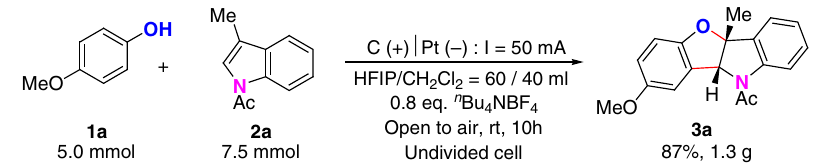
Fig. 5 Electrochemical gram scale reaction. Gram scale synthesis of benzofuro[3,2-b]indoline 3a